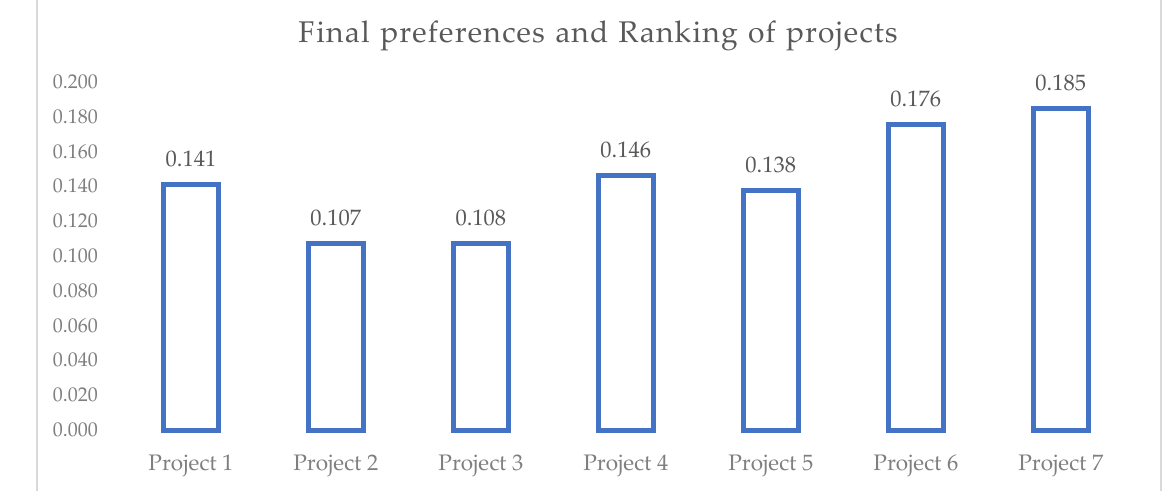
Figure 4 . Final preferences and ranking of projects . Figure 4. Final preferences and ranking of